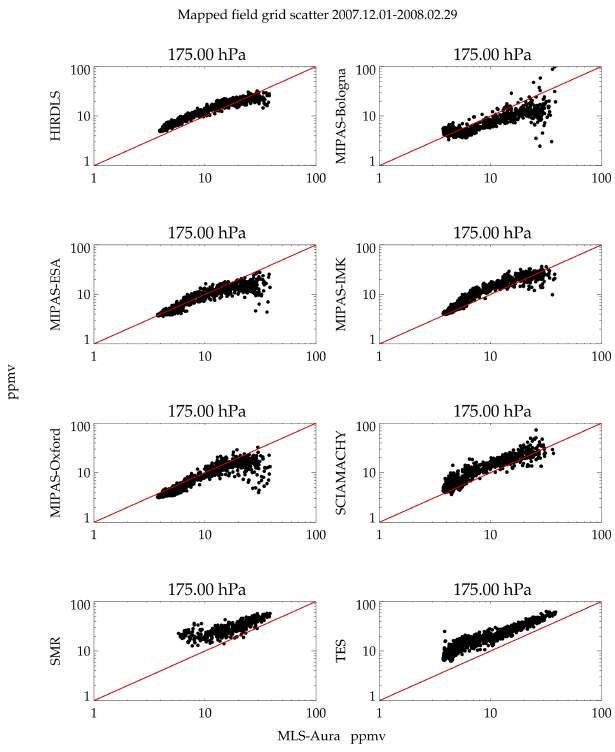
Figure 23. Scatter plot for 175hPa and December 2007–February 2008 (MLS-Aura versus y instrument) of the map grid values in Fig.